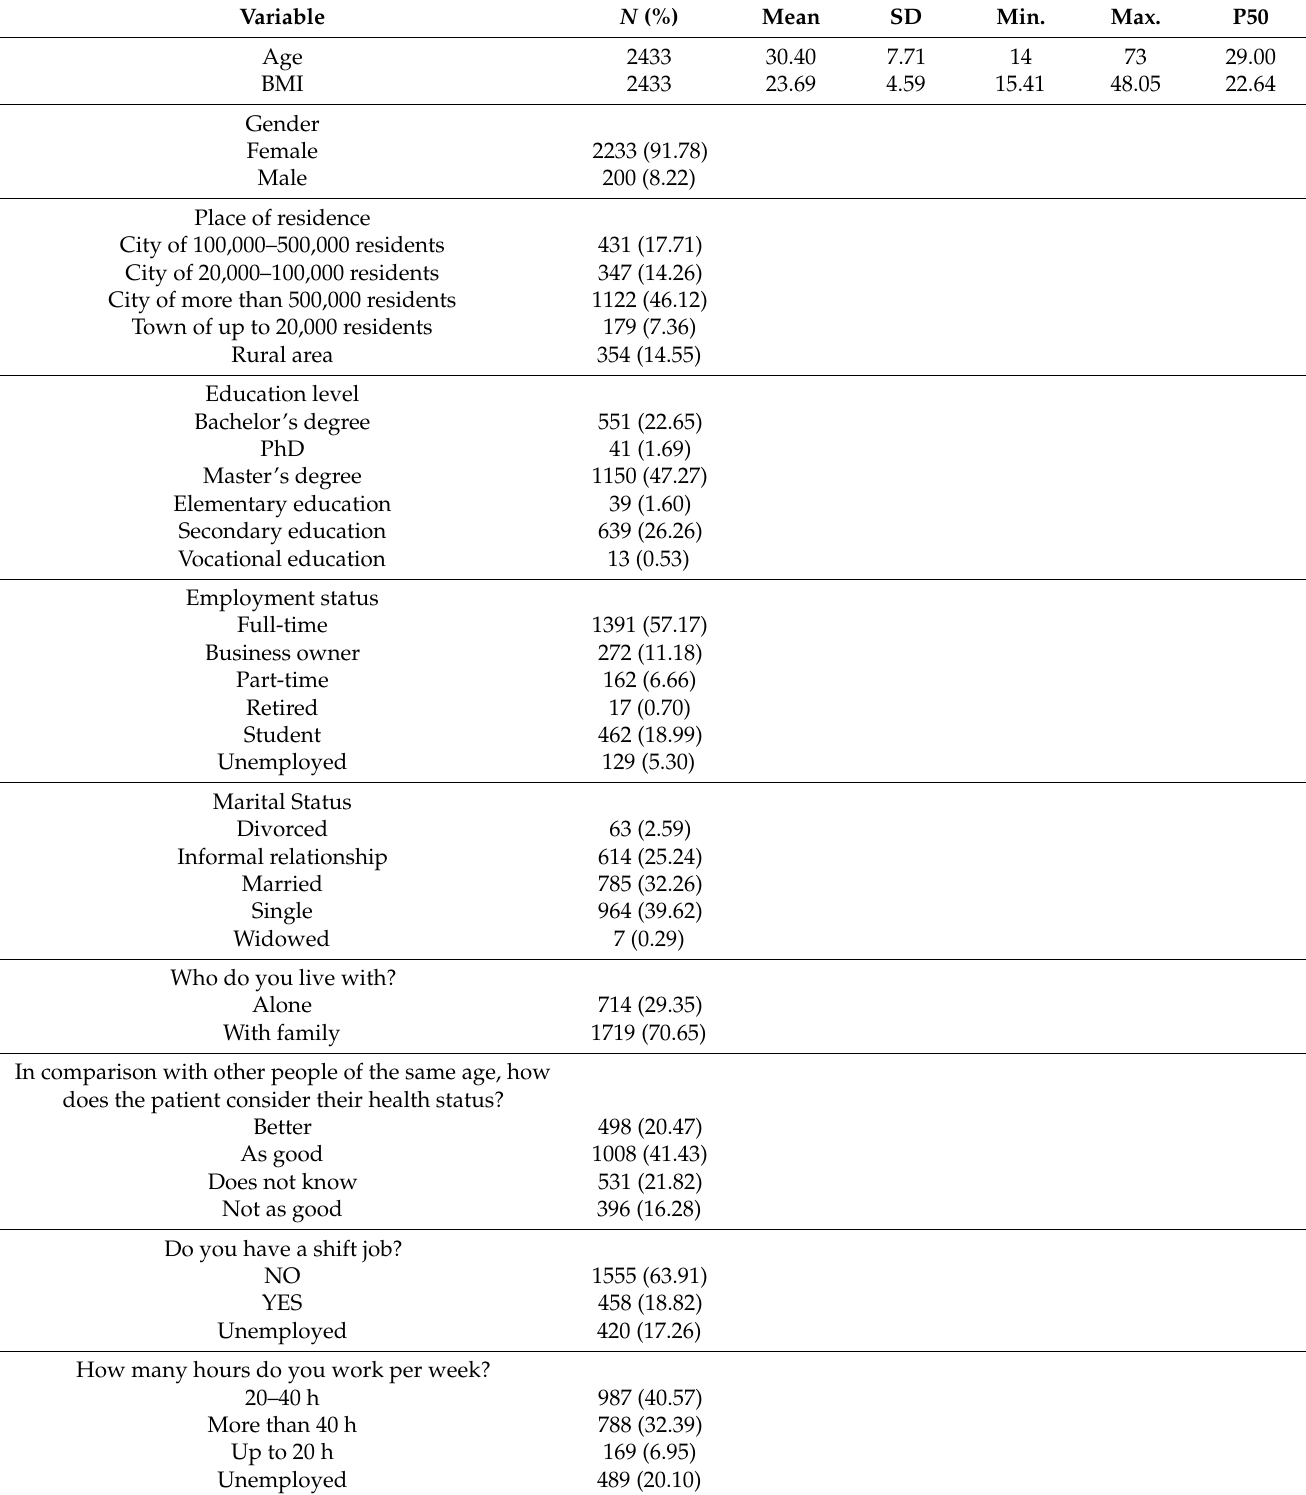
Table 1. Socio-demographic and health-related characteristics of the study sample ( N =